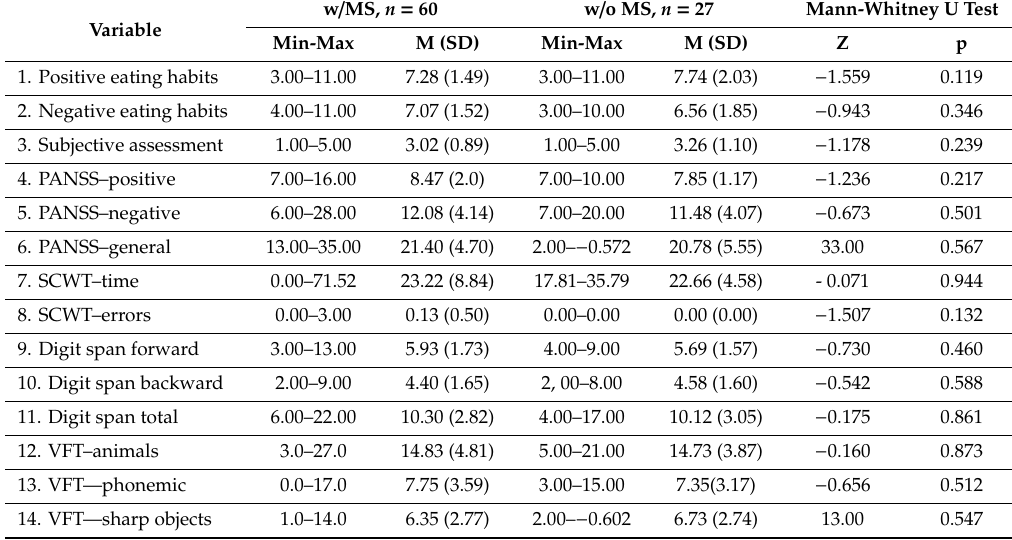
Table 3. Comparison of schizophrenia patients with and without